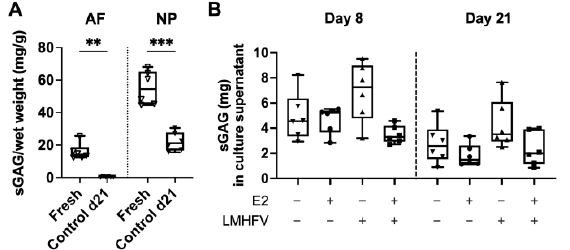
Figure A4. ( A ) Sulphated glycosaminoglycan (sGAG) content in fresh AF and NP tissues and in samples from the control group after 21 days of organ culture. ( B ) Amount of sGAG released to the culture supernatant of control, E2, LMHFV and E2 + LMHFV IVD tissues after 8 and 21 days of organ culture. Results are presented in box plots ( n = 6 IVDs/group). Mann-Whitney test, ** p < 0.01, *** p < 0.001.